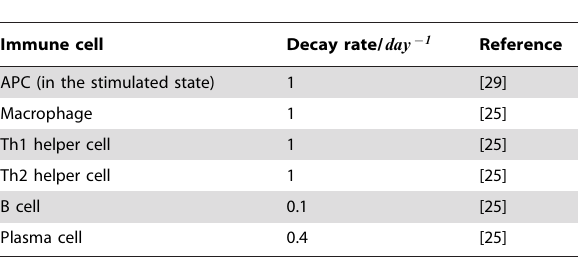
Table 3. Decay rates of different immune cells.